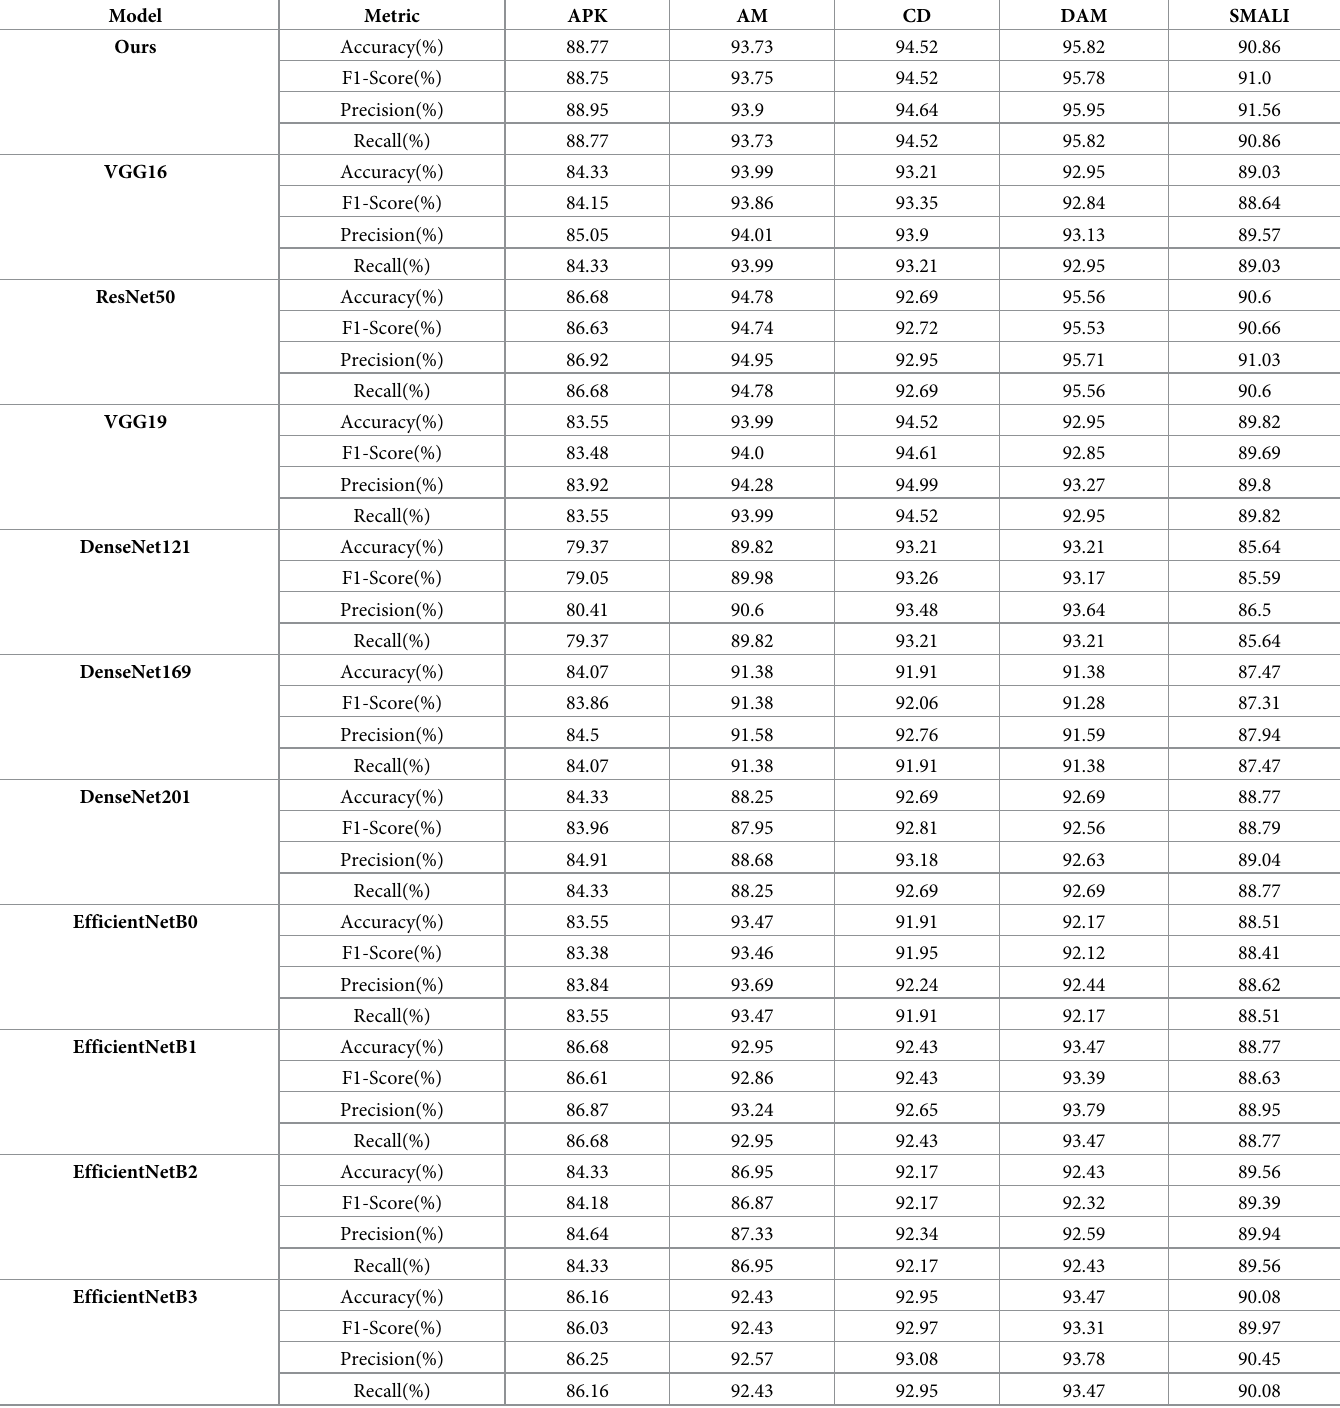
Table 5. Security performance of models on DREBIN